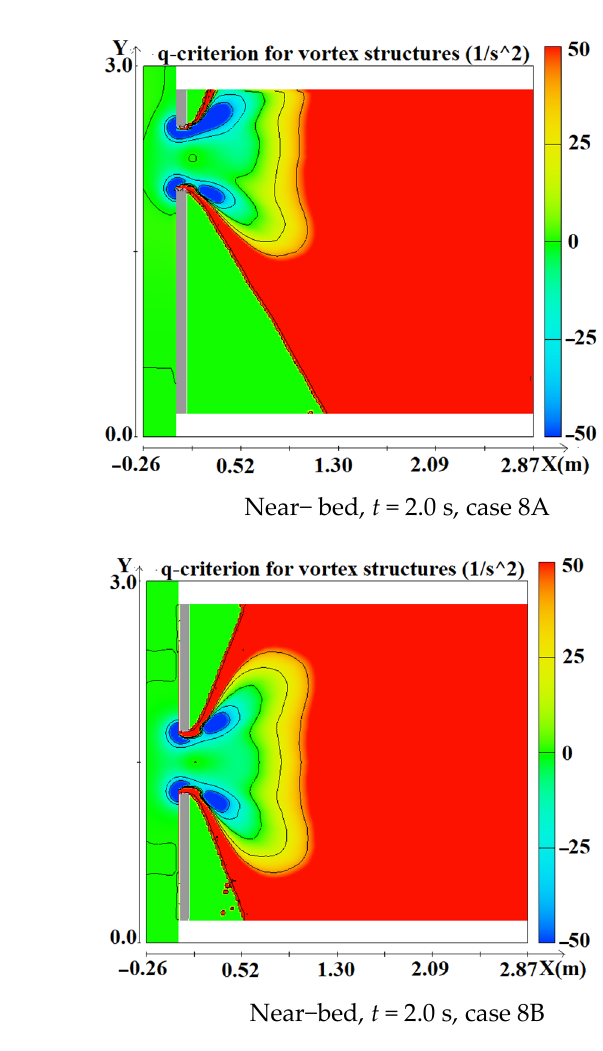
Figure 13. Near–bed q – criterion at the center of dam gate. Solid line–asymmetrical dam gate; dot line – symmetrical one